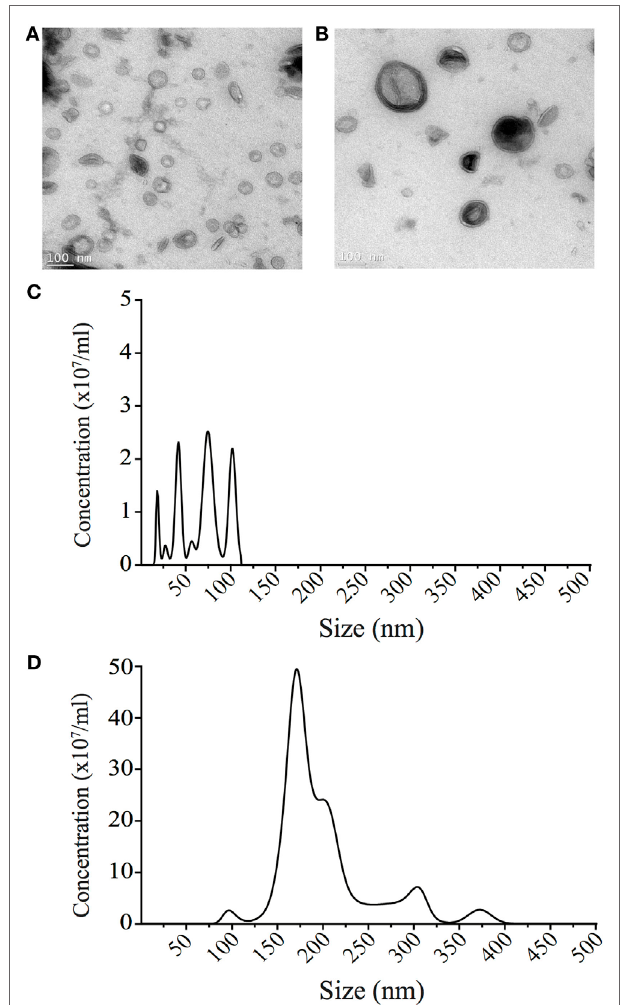
FigUre 2 | Small and large outer membrane vesicle (OMV) populations purified from a heterogeneous population of OMVs using sucrose gradient purification. (a) Transmission electron micrographs of small OMVs present in fraction 6 and (B) larger OMVs present in fraction 12. Scale bar represents 100 nm. (c) The sizes (nm) of OMVs found within fraction 6 containing small OMVs were determined using NanoSight Tracking Analysis and revealed four populations of OMVs ranging from 20 to 100 nm in size. (D) The size (nm) of OMVs found within fraction 12 containing larger OMVs was determined using NanoSight Tracking Analysis. Multiple populations of OMVs were contained within fraction 12, that ranged from 90 to 400 nm in